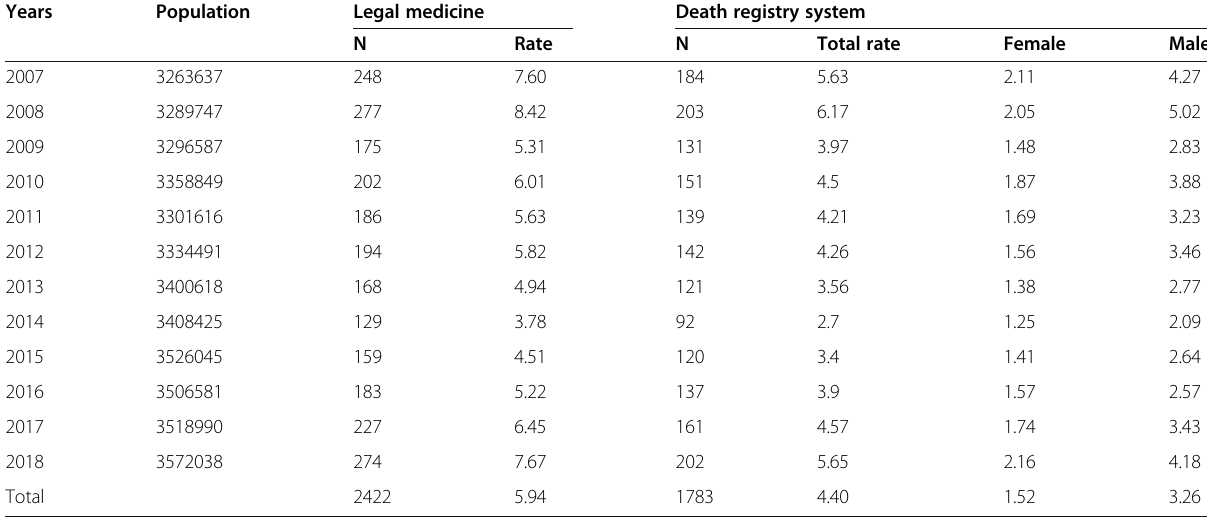
Table 2 Comparison of suicide rates between legal medicine statistics and Death Registry Information System in East Azerbaijan Province during the period 2007 – 2018